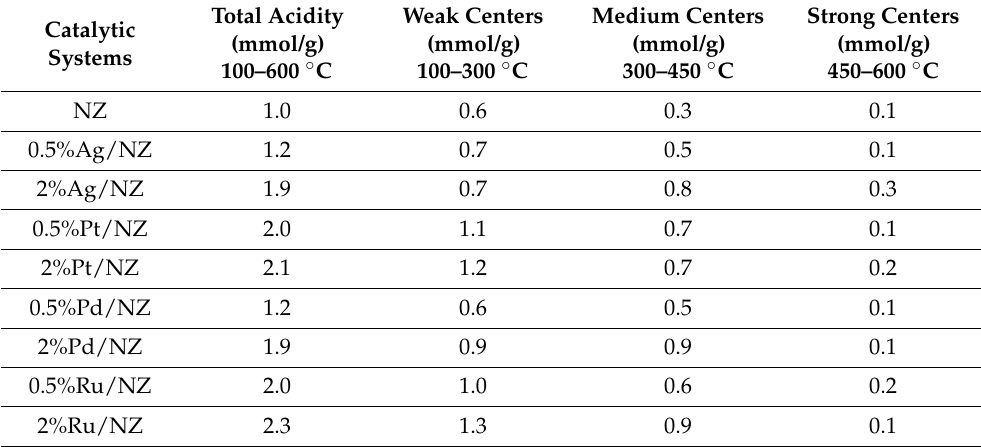
Table 5. The amount of NH 3 adsorbed on support surface (calcined in an air atmosphere for 4 h at 400 ◦ C), monometallic reduced catalysts (reduction at 300 ◦ C in a mixture of 5% H 2 –95% Ar mixture), calculated from the NH 3 - temperature programmed reduction (TPD) profiles.